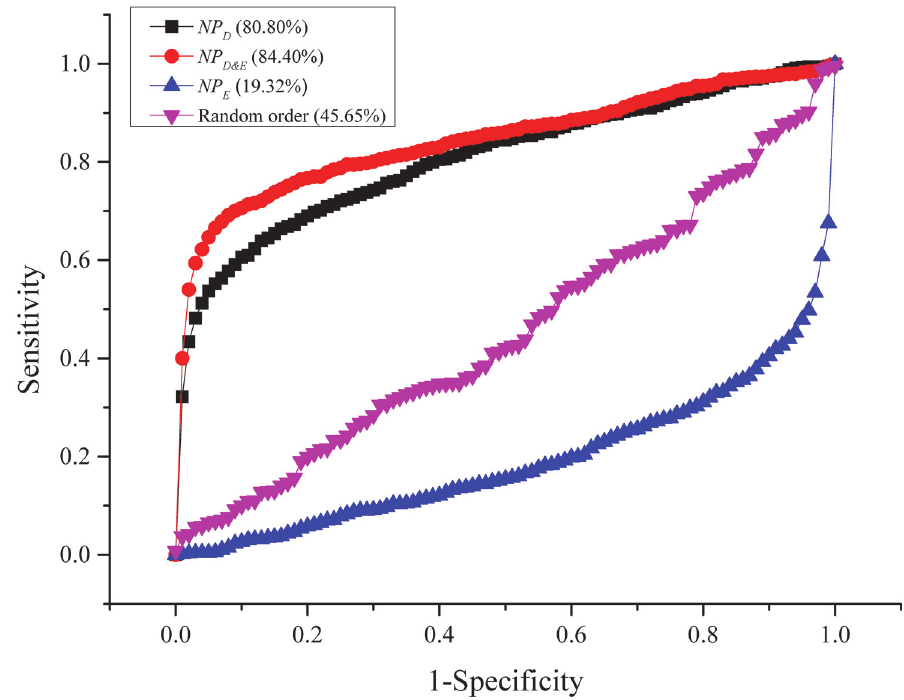
Fig 4. ROC curves.